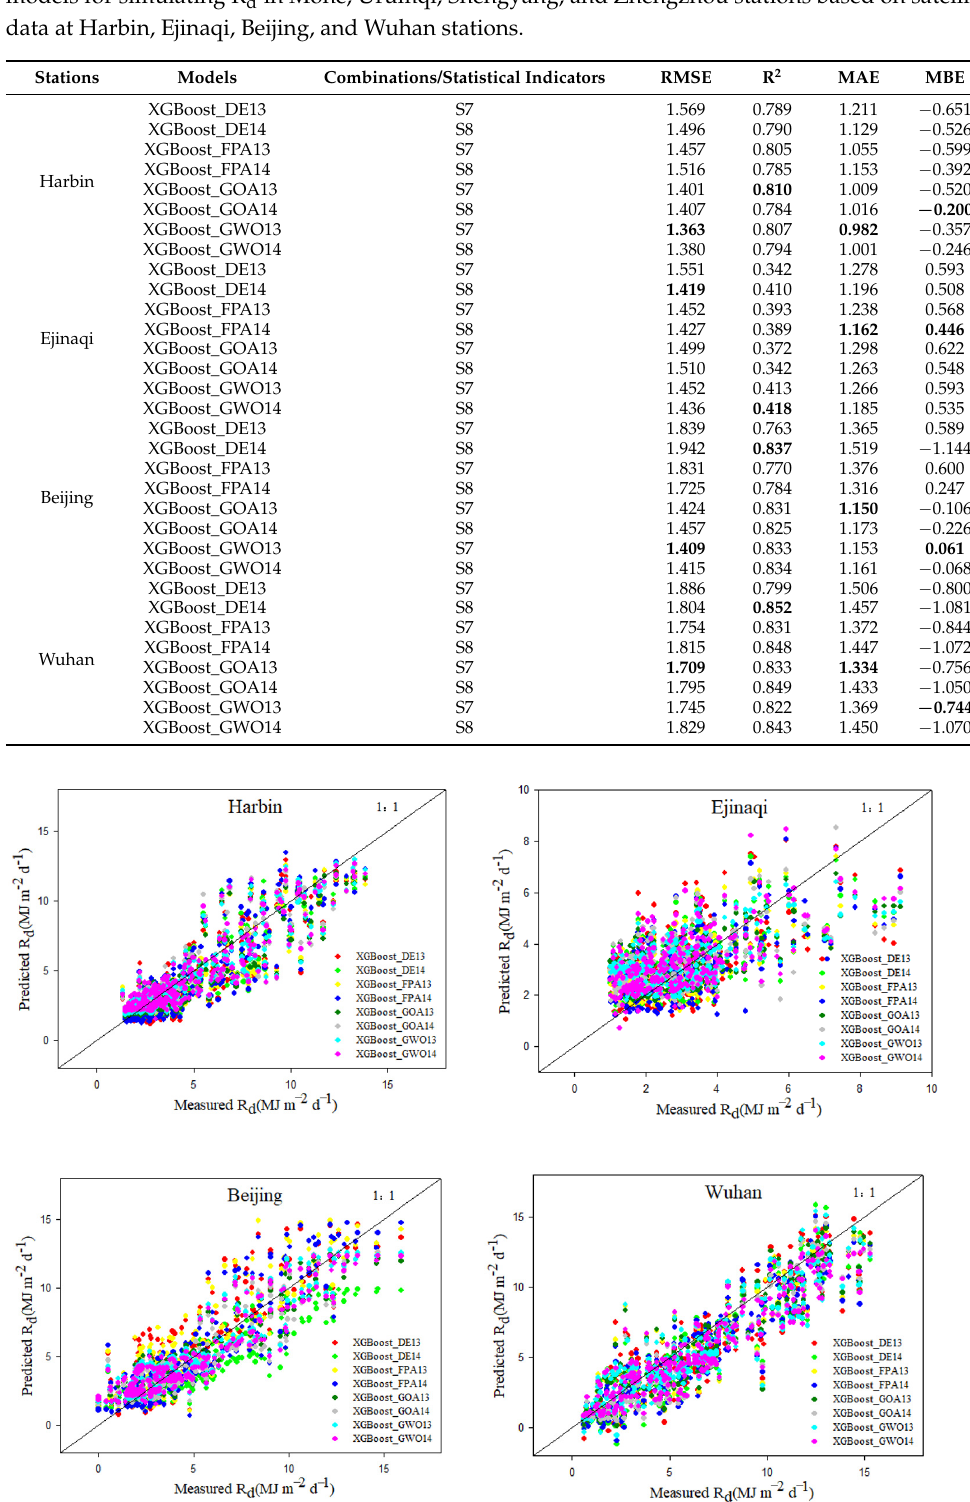
Figure 6. Scatter plot of R d predicted by the coupling models based on Himawari-7 data at other stations in cross-station application.